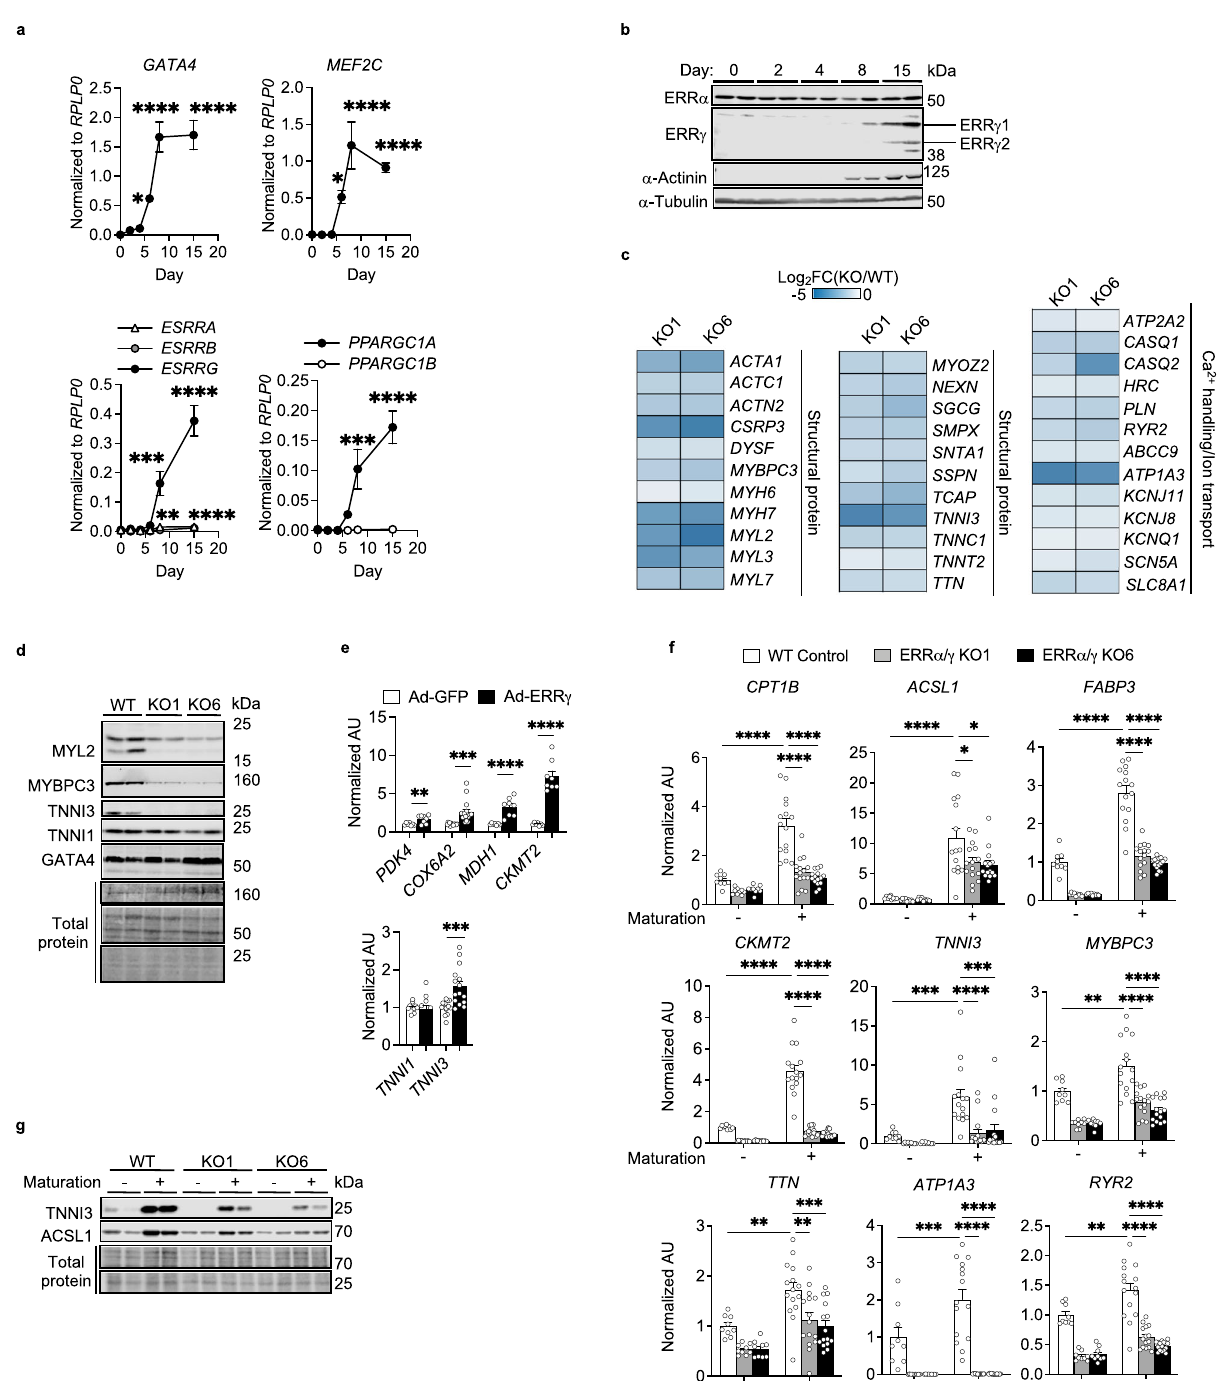
(Supplementary Fig. 2b) as occurs during the fetal to adult transition in vivo 10,14 Consistent with the gene expression pro fi le, ERR γ OE increased 3 H-palmitate oxidation rates (Supplementary Fig. 2c) together with an increase in acylcarnitine species indicative of increased FAO fl ux (Supplementary Fig. 2d). Other metabolite signatures of metabolic maturation in ERR γ OE hiPSC-CMs included increased levels of TCA cycle intermediates (Supplementary Fig. 2e), reduced lactate consistent with decreased glycolytic fl ux (Supplementary Fig. 2e), and increased levels of mitochondrial BCAA degradation products (C3, C4, and C5 acylcarnitine species; Supplementary Fig. 2f). Levels